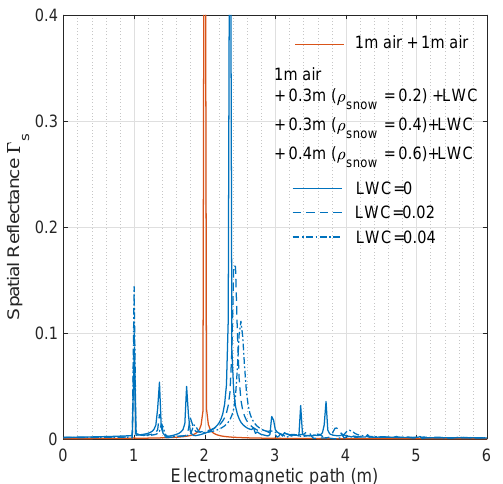
Figure 6. SFCW radar simulated spatial reflectances with the matrix method. Effect of wetness (LWC) in the reflectance (blue lines). Thicknesses (m) = [1,0.3,0.3,0.4]. Relative densities of the structure = [0,0.2,0.4,0.6], LWC = 0 (solid line), 0.02 (dashed line), and 0.04 (dot-dashed line).